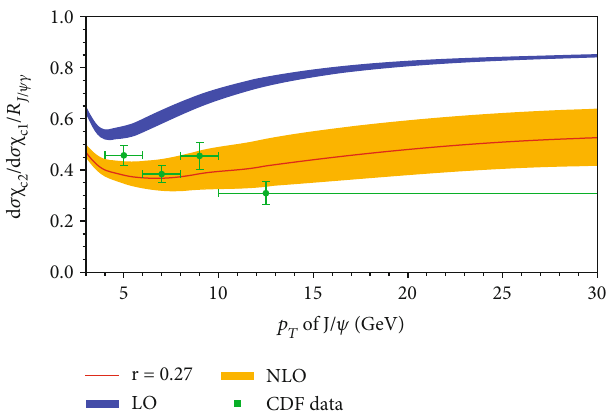
∣ <1 . Figure taken from Ref. [108]. cJ